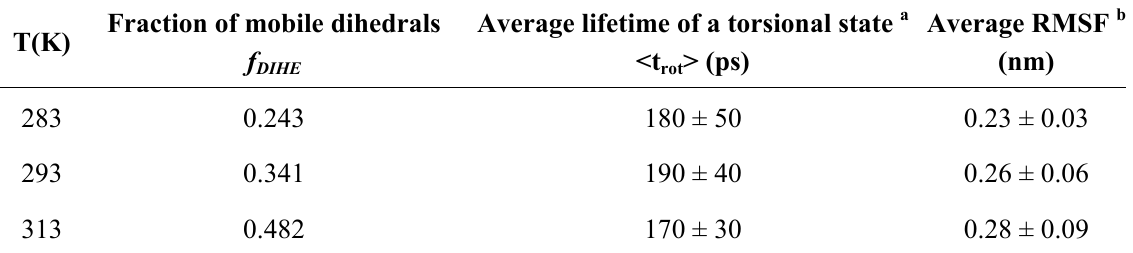
Table 2. Backbone torsional dynamics of PVA and average root mean squared fluctuation of carbon atoms for whole